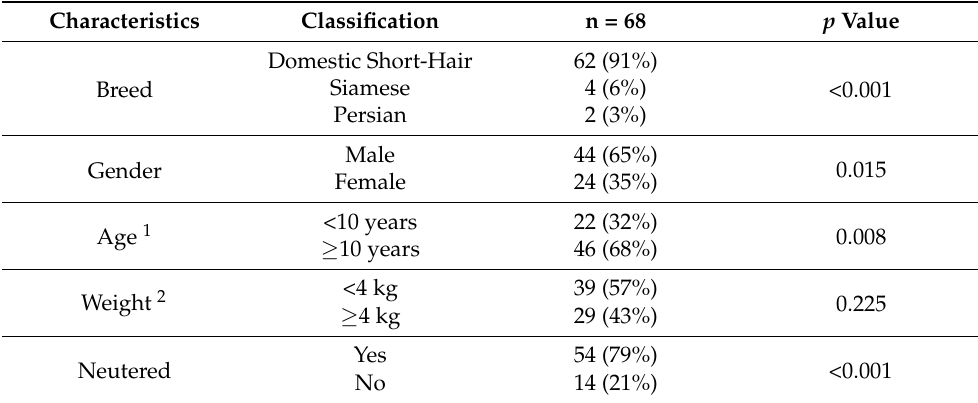
Table 1. Signalment of clinically ill cats identified with adrenomegaly. Characteristics Classification n = 68 p Value Domestic Short-Hair 62 (91%) <0.001Siamese 4 Breed